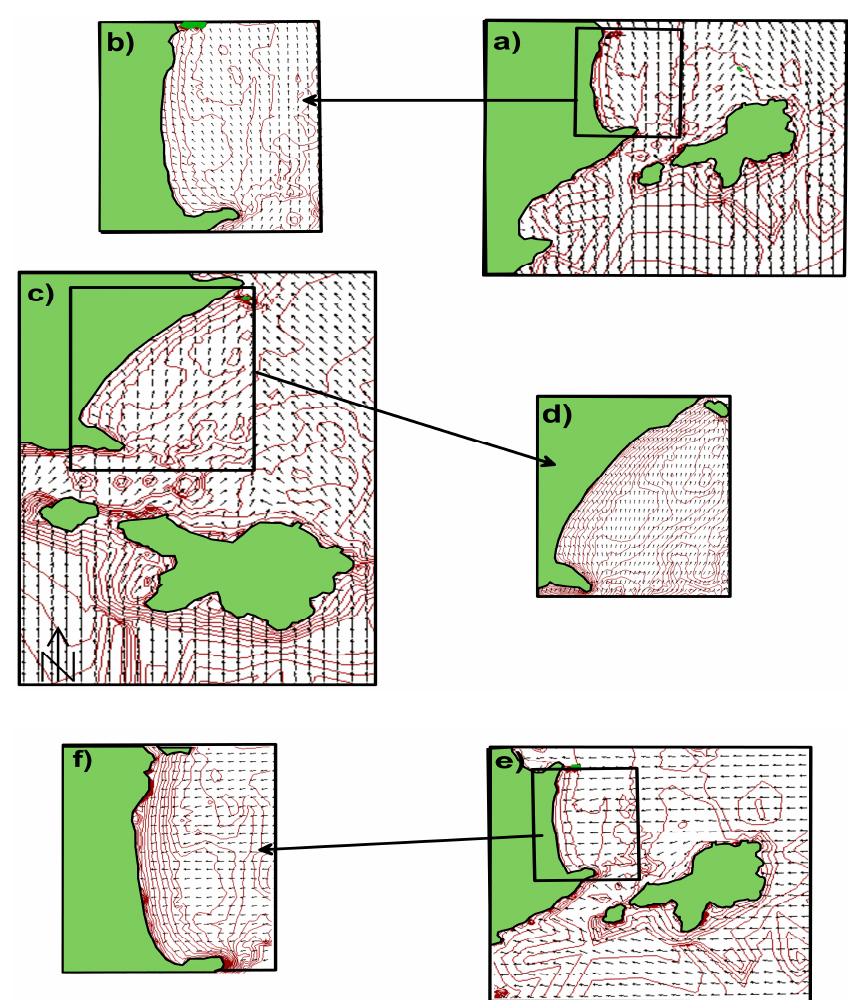
Figure 10. Illustrations of modelled wave vectors based upon the highest astronomical tidal range for, ( a ) southwesterly offshore waves; ( b ) southwesterly nearshore waves; ( c ) southerly offshore waves; ( d ) southerly nearshore waves; ( e ) southeasterly offshore waves and ( f ) southeasterly nearshore waves.